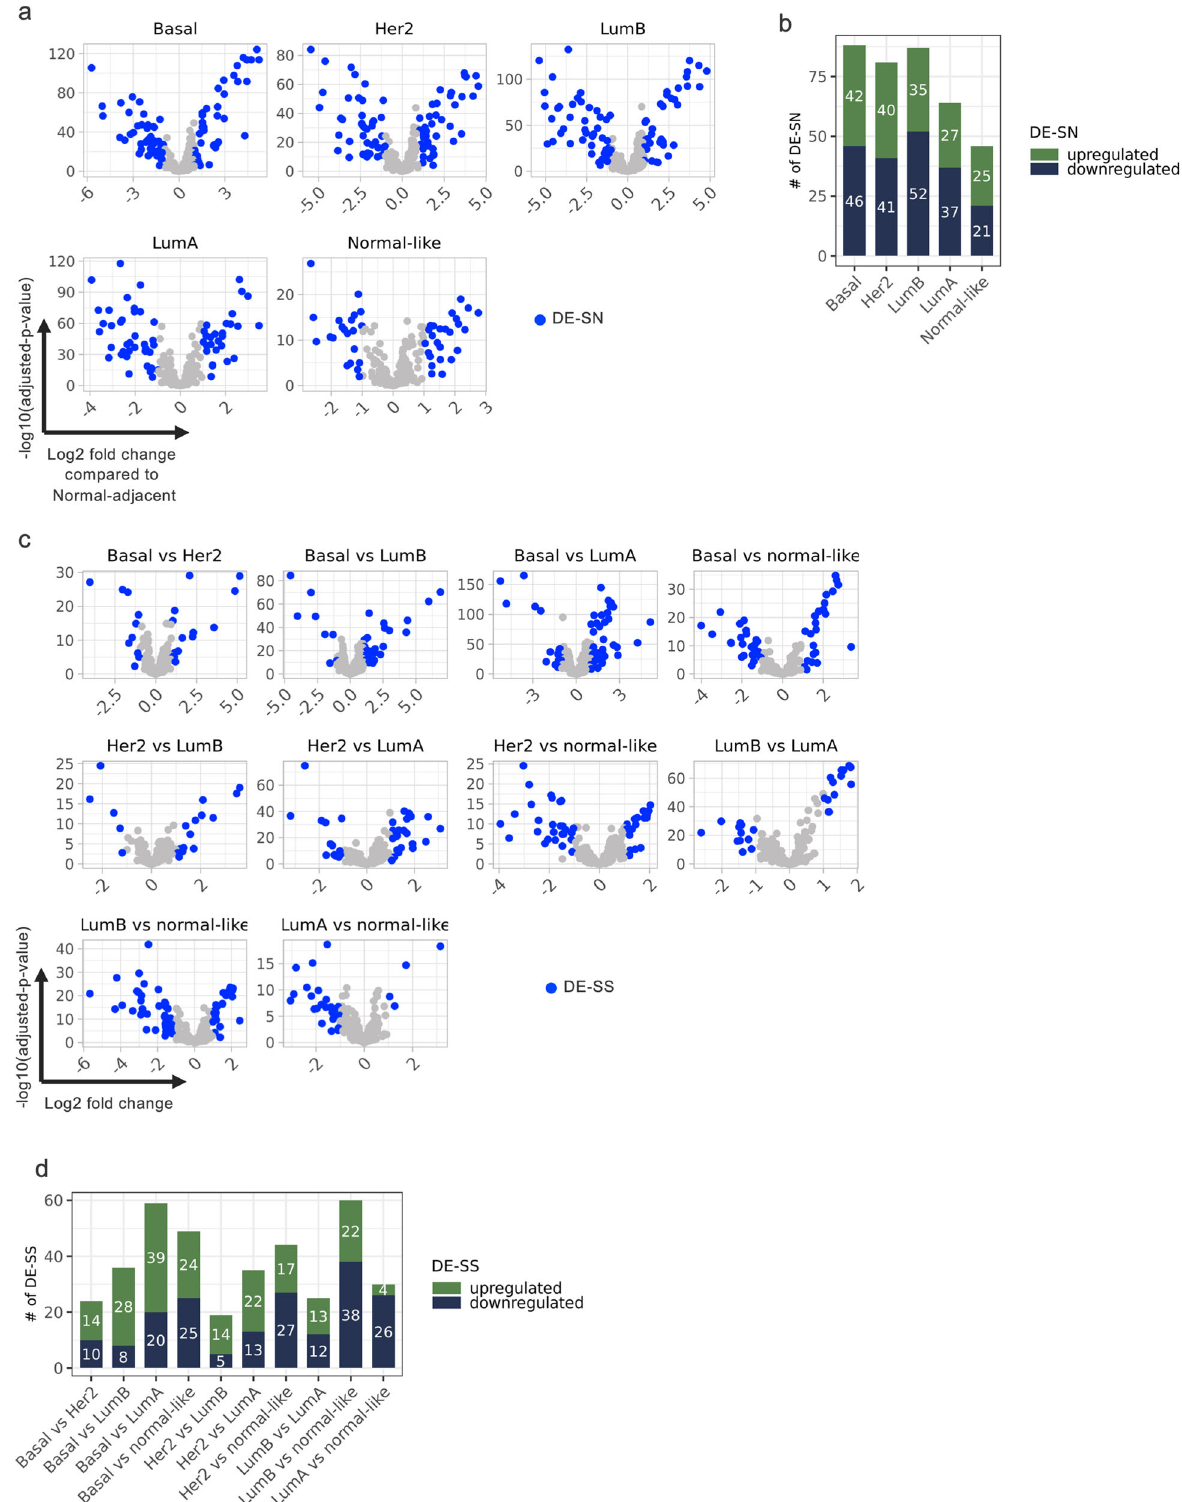
Fig. 2 Identi fi cation of DE-SN and DE-SS in PAM50 subtypes. Volcano plots depicting the level of ASR genes in the indicated PAM50 subtypes compared to Normal-adjacent ( a ) or to each other ( b ). The log2 fold-change differential expression and the – log10 (adjusted p -value) are shown on the x -axis and y -axis, respectively. The points correspond to all ASR genes and the blue highlighted points represent the DE-SN ( a ) and DE-SS ( c ), which exhibit fold-change greater than 2 and adjusted p -value less than 0.05. b and d Bar plots depicting the number of DE-SN and DE-SS in a and c , respectively. The colors of the bars indicate whether the DE-SN ( b ) or DE-SS ( d ) are upregulated (green) or downregulated (blue). The numbers inside the bar correspond to the number of upregulated or downregulated DE-SN ( b ) or DE-SS ( d ). Comparisons are shown under each bar and the number of DE-SN (# of DE-SN) or DE-SS (# of DE-SS) are shown on the y -axis.